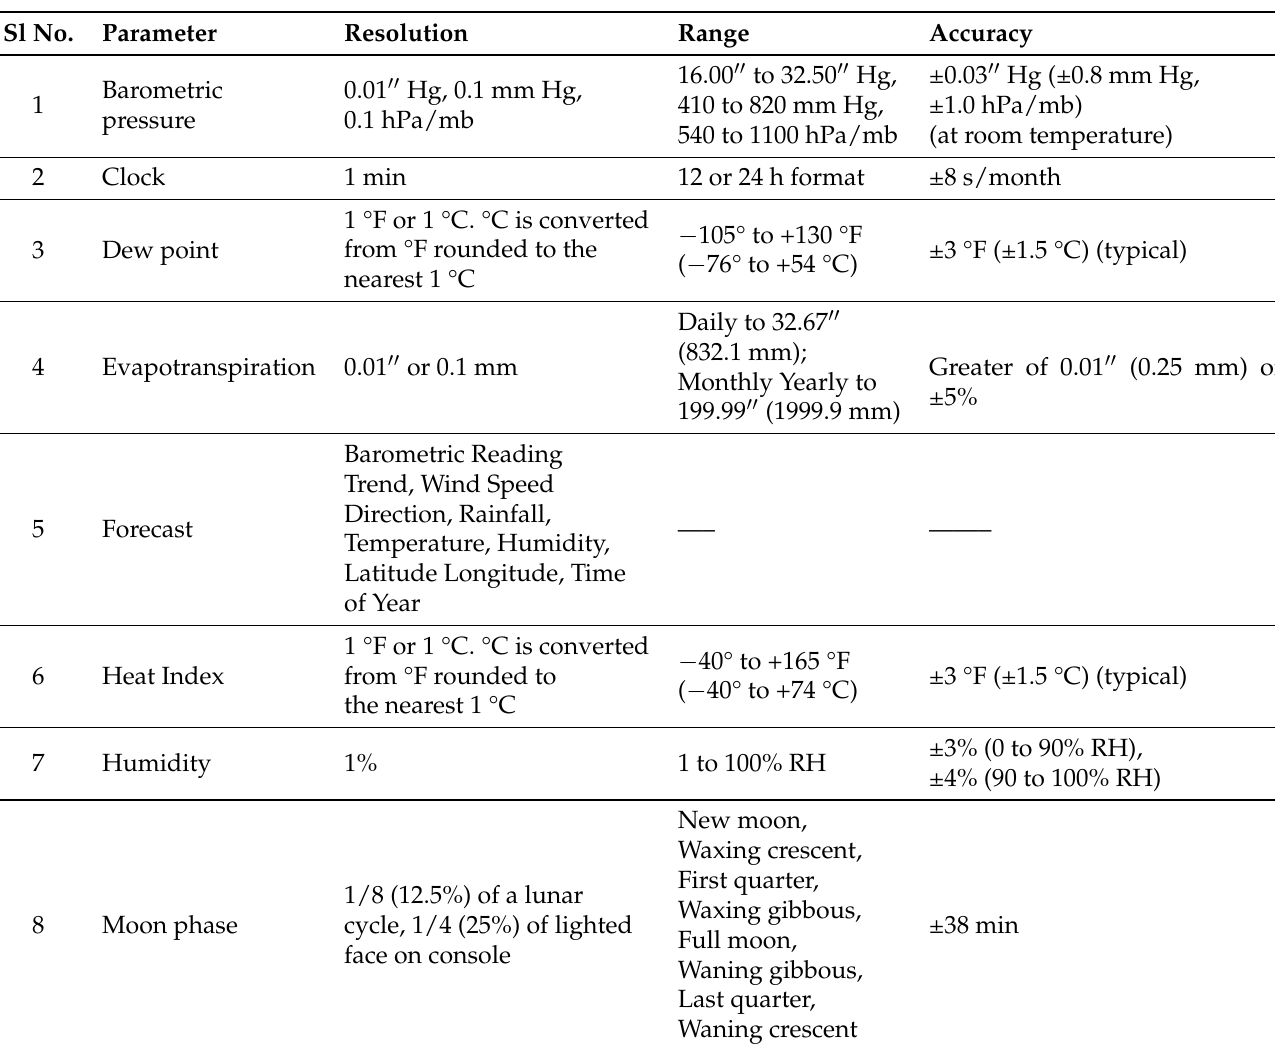
Table 5. Console